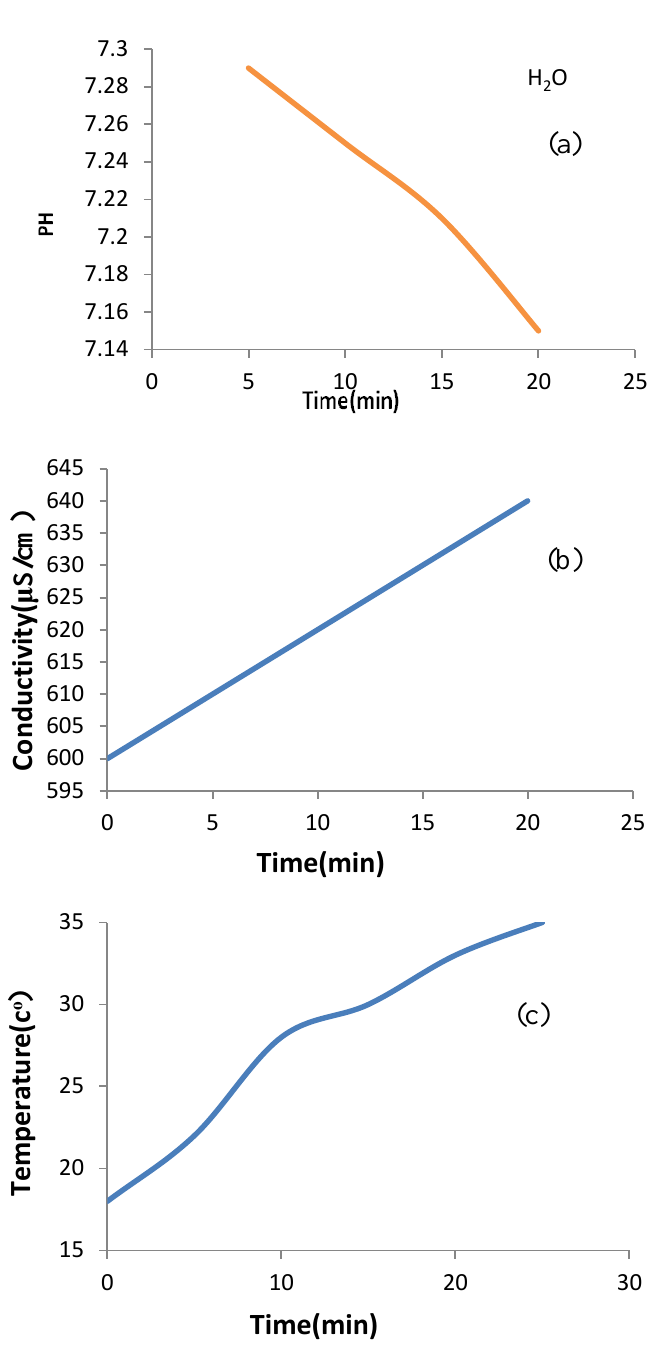
Fiq.4: (a) Water PH variation with the time (b) water conductivity variation with the time (c) water temperature variation with the